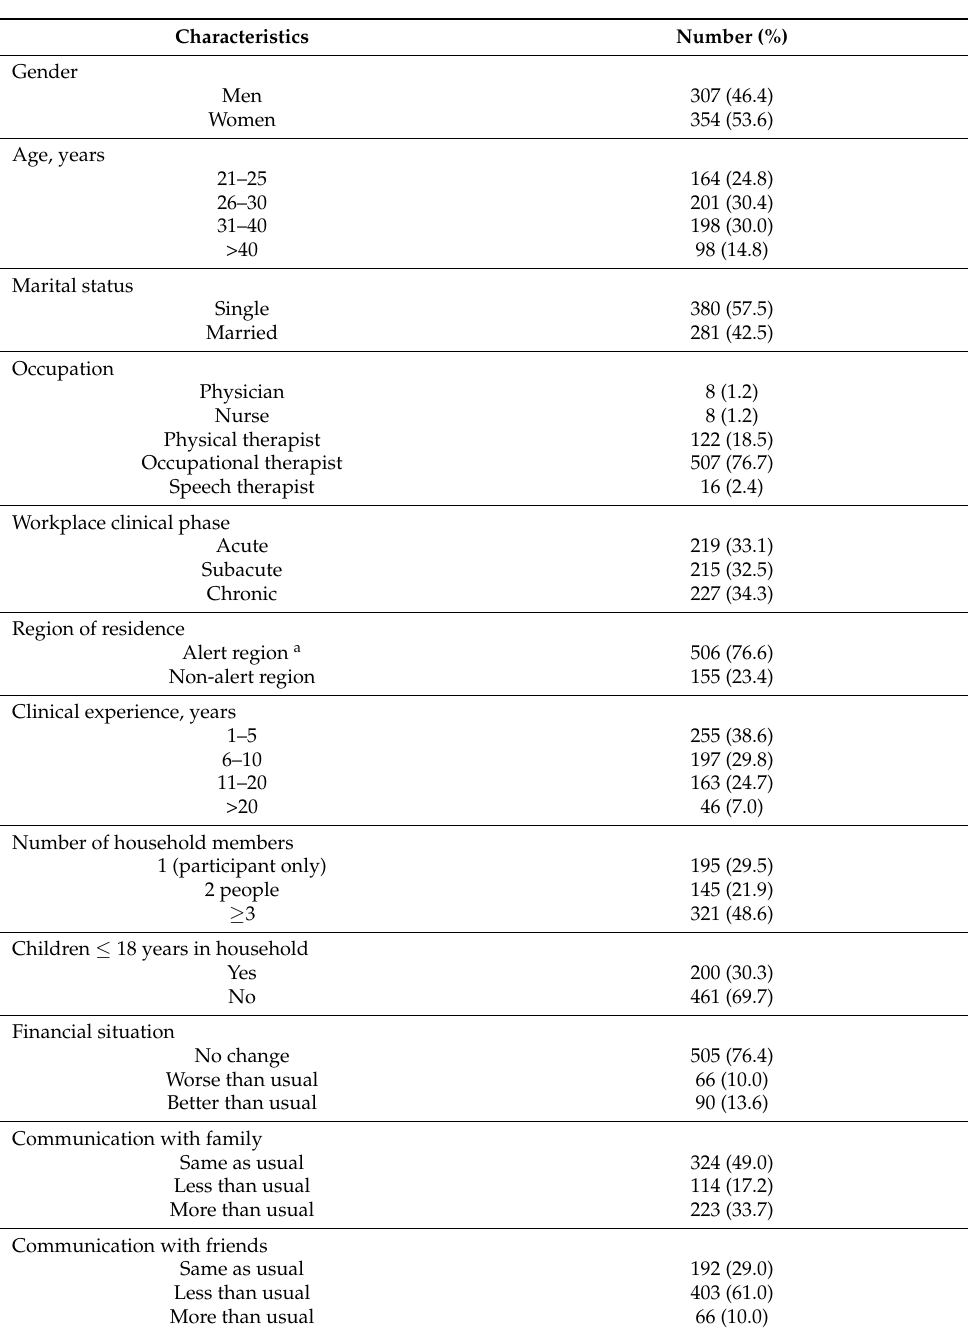
Table 1. Demographic characteristics of study participants ( N =